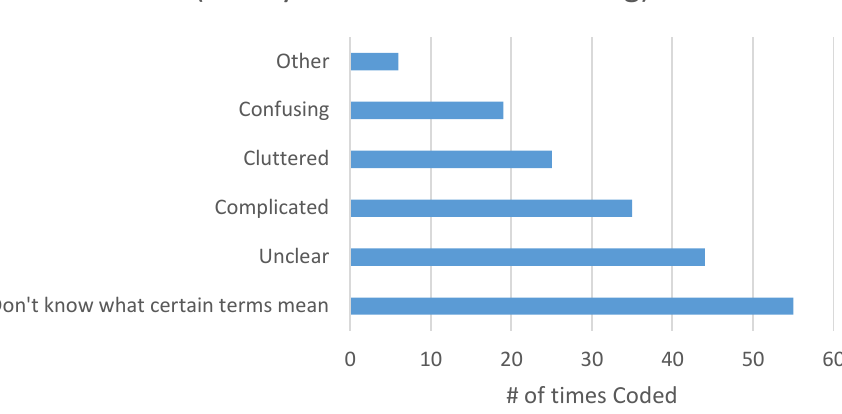
Figure 7. Coded Responses to Newspaper Advertisements (Clarity: Level of Understanding).